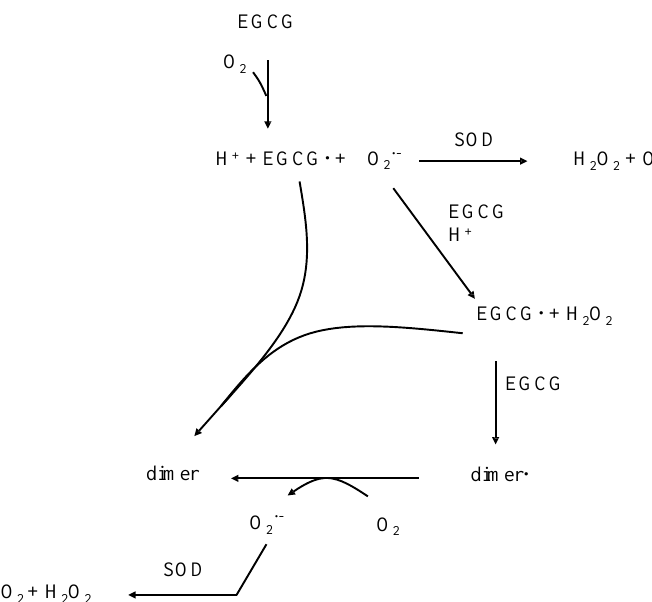
Figure 2. Mechanism of epigallocathechin gallate (EGCG) auto-oxidation and dimerization adapted from [30].